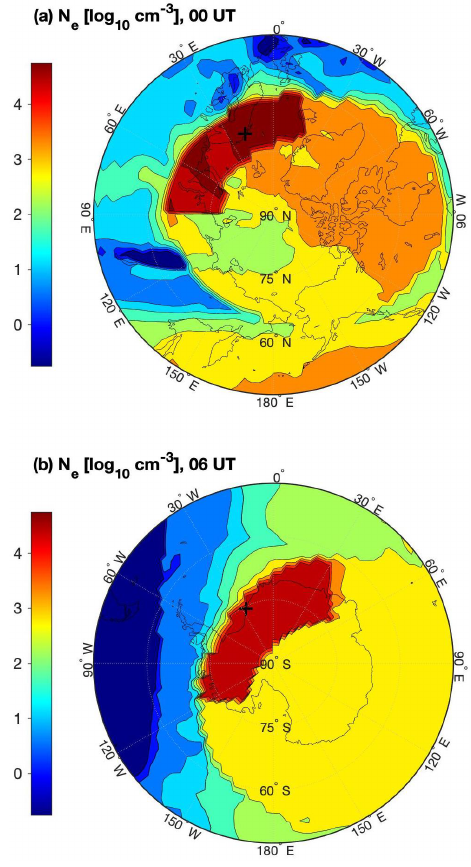
Figure 1. An example of simulated electron concentrations on 18 January 2010, at ∼ 78km altitude. The locations of the Tromsø and Halley stations are marked with the black crosses in the NH (a) and the SH (b) ,